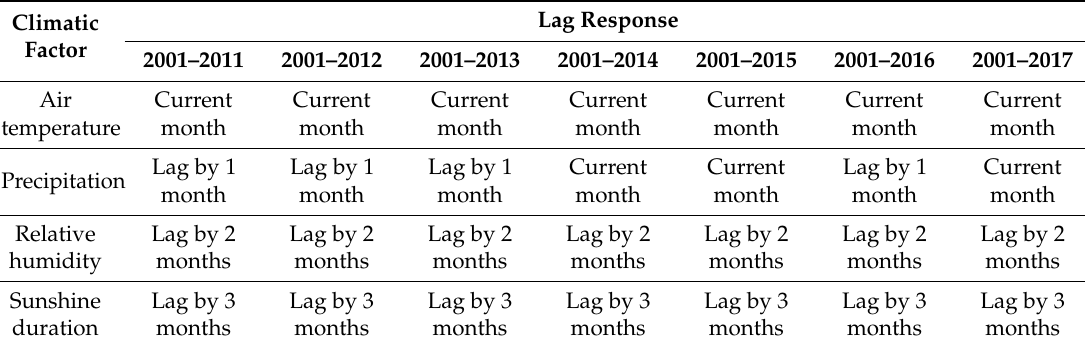
Table 3. The lag response of NDVI to Climate Factors in seven time